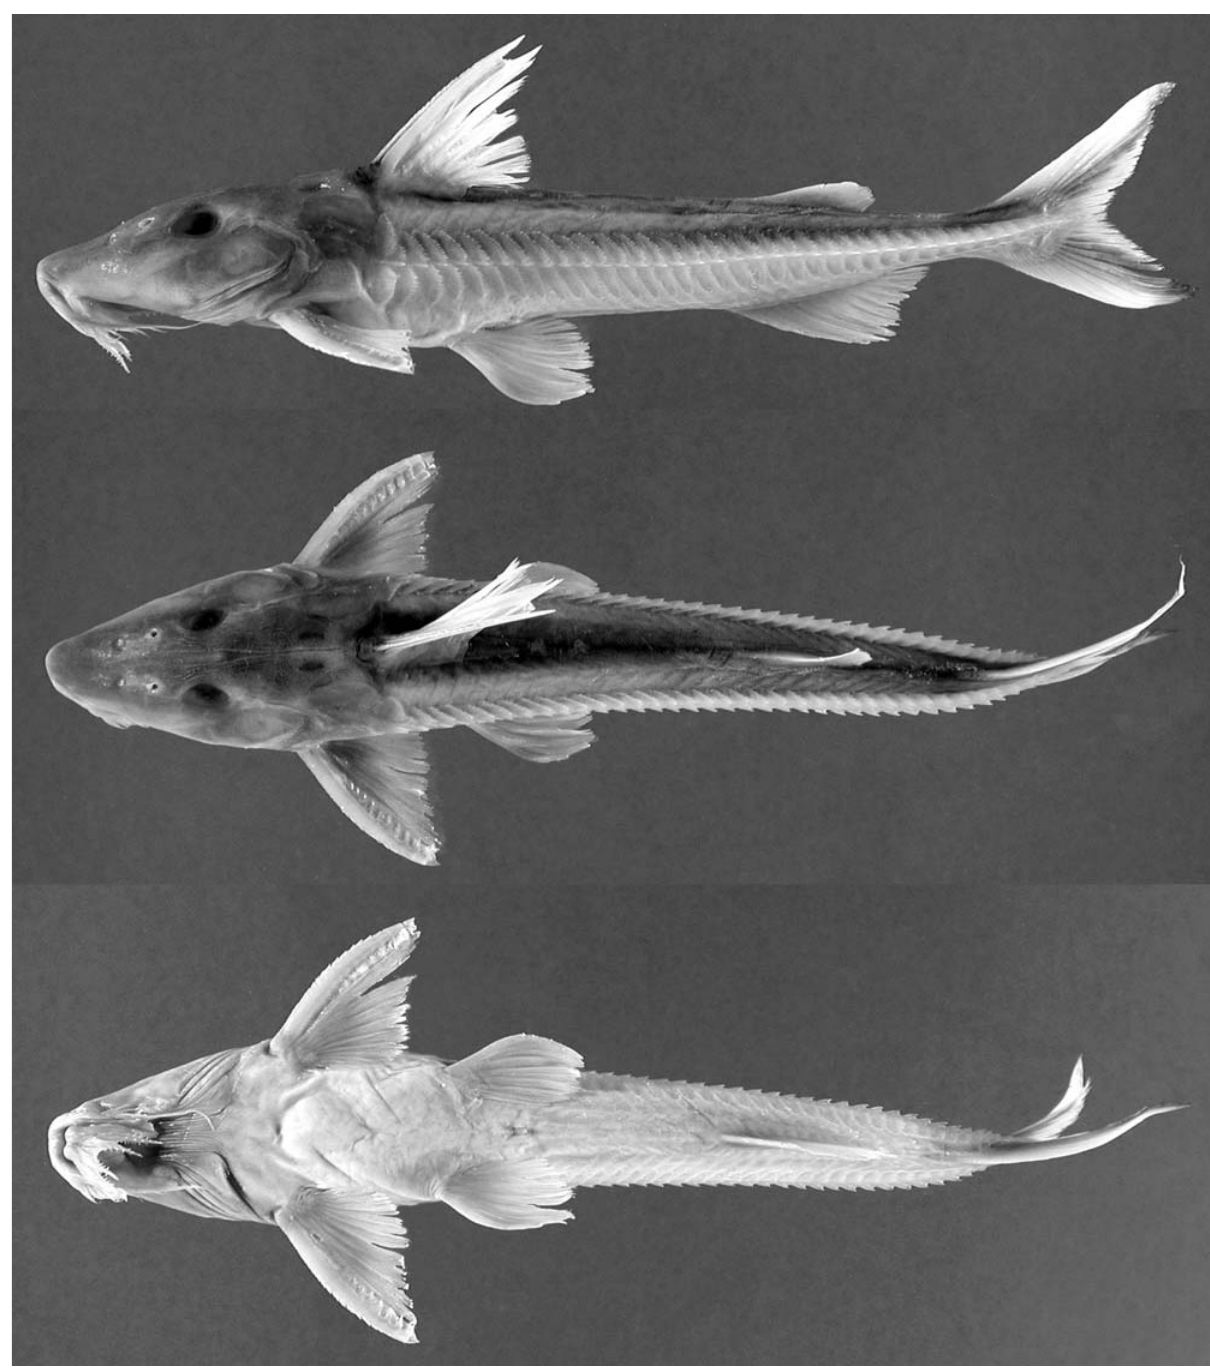
Fig. 20. Leptodoras nelsoni , paratype ANSP 182200 (SL 162 mm), río Apure (Orinoco dr.), Apure,